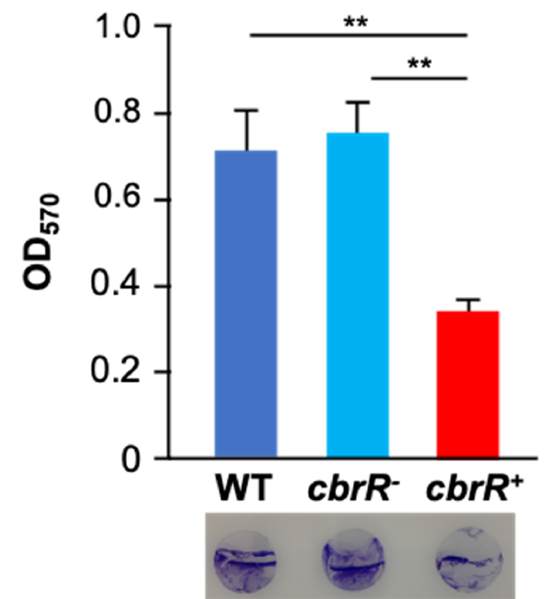
Figure 7. Overexpression of CbrR leads to a decrease in biofilm formation. Quantitative and qualitative assessment of biofilm formation by WT, cbrR − , and cbrR + was performed using crystal violet staining of 72 h C. jejuni biofilms grown in 24-well microtiter plates. The graph shows biofilm formed (measured by OD 570 ), while the circles at the bottom are crystal violet-stained coverslips representative of those subjected to SEM. Wild type and cbrR − cells retain the ability to effectively form biofilm; however, overexpression of CbrR leads to a biofilm formation deficiency in cbrR + (** p < 0.01). One-way ANOVA with Tukey’s multiple comparisons test was performed for statistical analysis (GraphPad Prism 9, San Diego, CA, USA). Experiments were performed with triplicate samples and repeated three times.